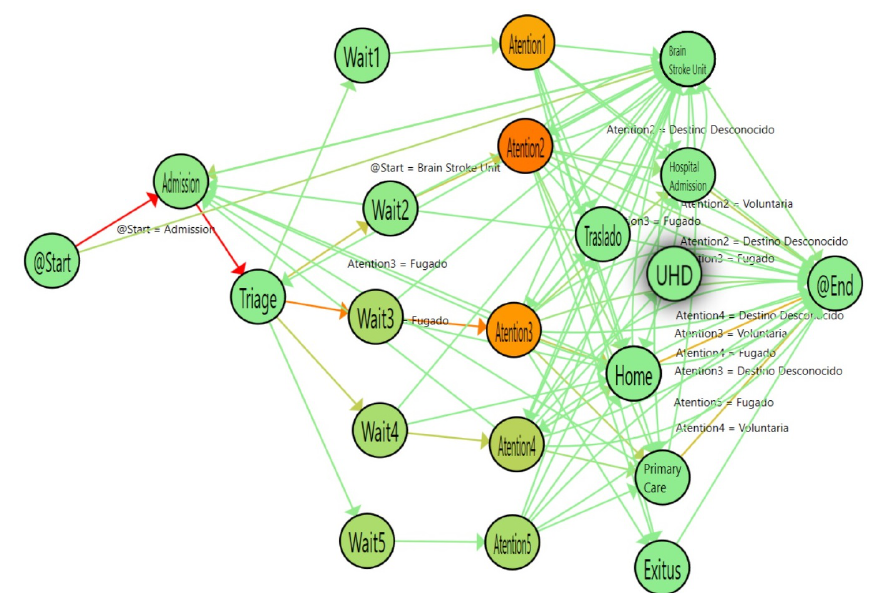
Figure 10. Emergency Room flow determined for patients aged 65+ years.